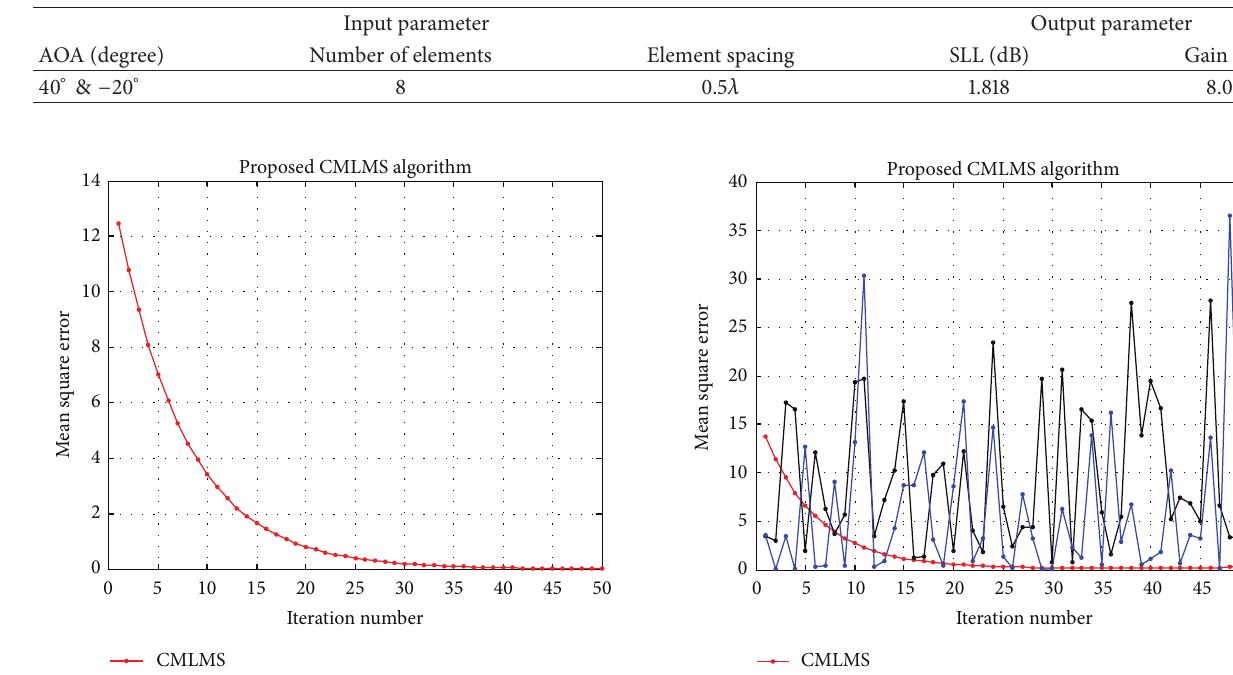
Table 1: Input and output estimates.